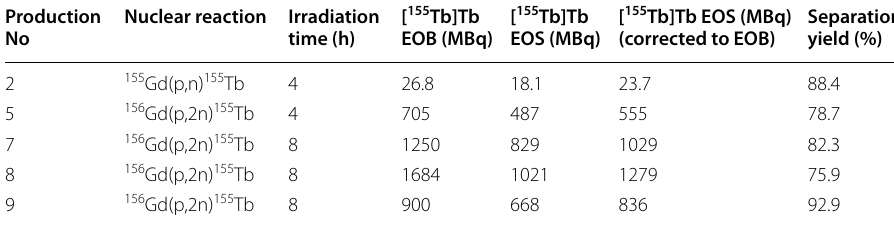
Table 2 Selected terbium-155 production runs, indicating measured activity EOB and EOS for each run Production No